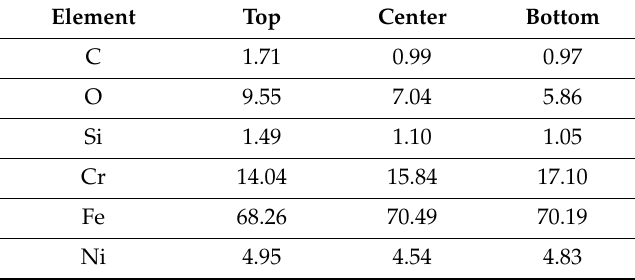
Table 4. Mass ratios of di ff erent elements at the top, center, and bottom of the microhole cross section. Element Top Center Bottom